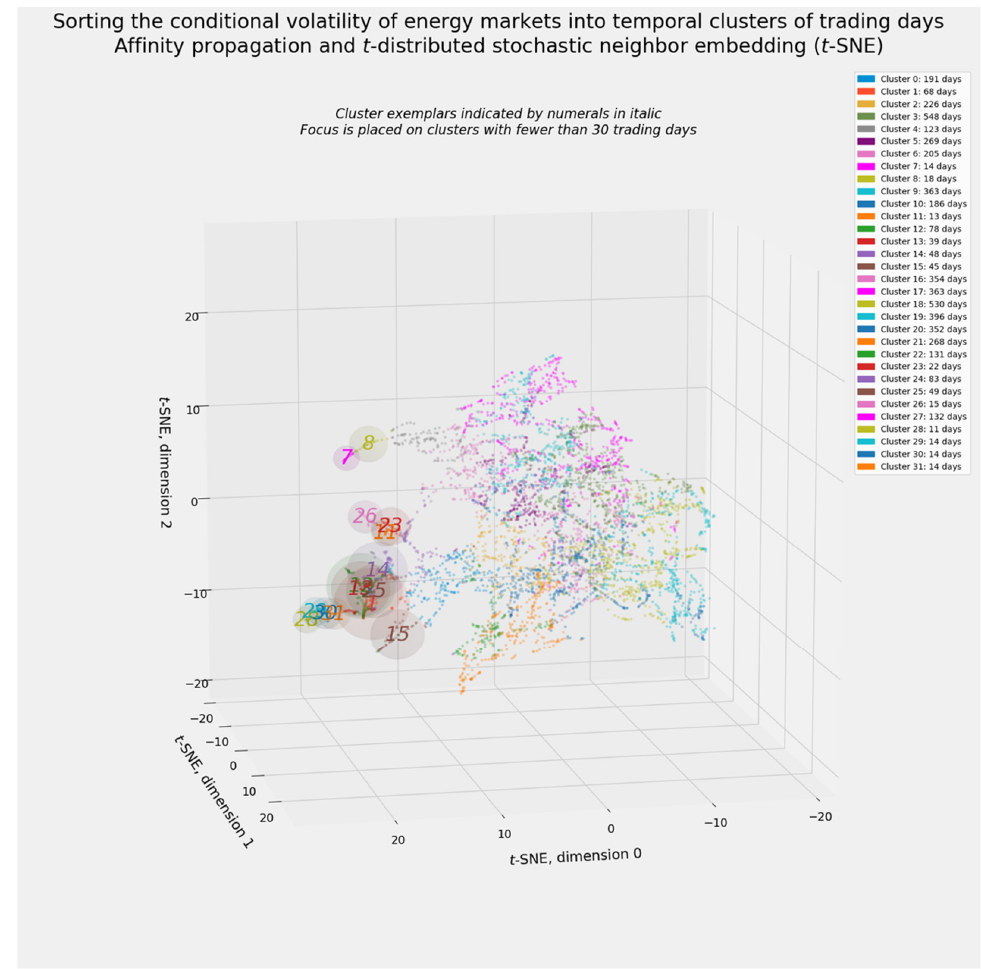
Figure 31. Affinity propagation of energy-related markets—A t -SNE manifold, with clusters of interest indicated by their synthetic centroids.